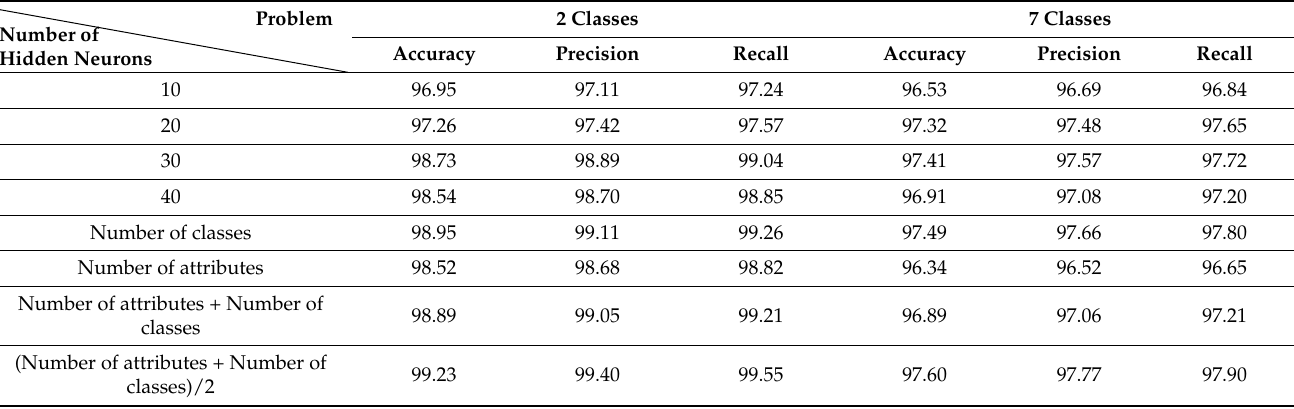
in terms of accuracy, precision, and recall